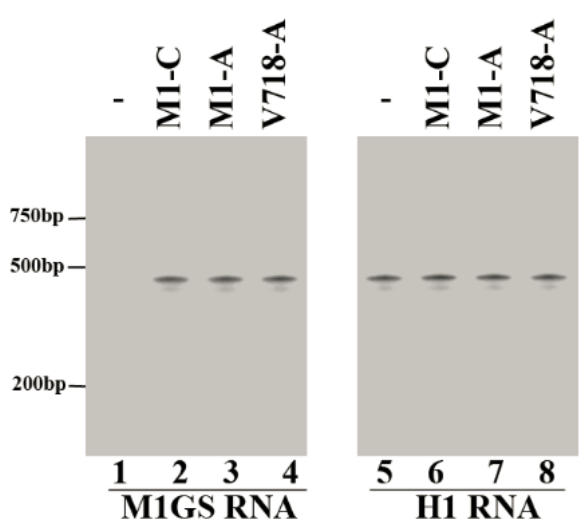
Figure 2. Expression levels of ribozymes in cultured cells. Northern blot analyses were performed using RNA samples (30 µg) prepared from parental U251 cells (-, lanes 1 and 5) and cells expressing M1-C (lanes 2 and 6), M1-A (lanes 3 and 7), and V718-A (lanes 4 and 8). Human H1 RNA control (lanes 5–8) (the RNA subunit of human RNase P and a nuclear RNA) [31,41].